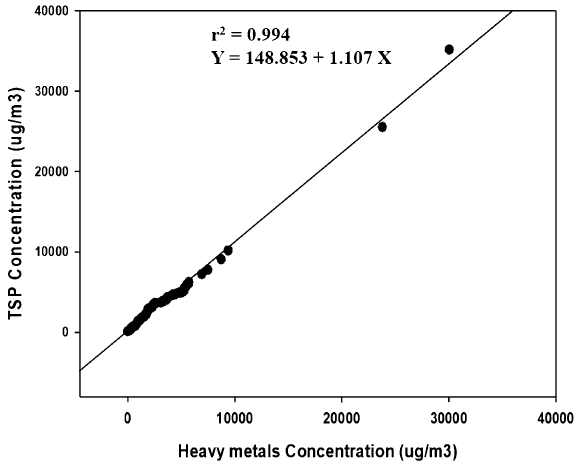
Figure 4. Distribution of heavy metals and TSP. All the concentrations are arithmetic means (N = 107).